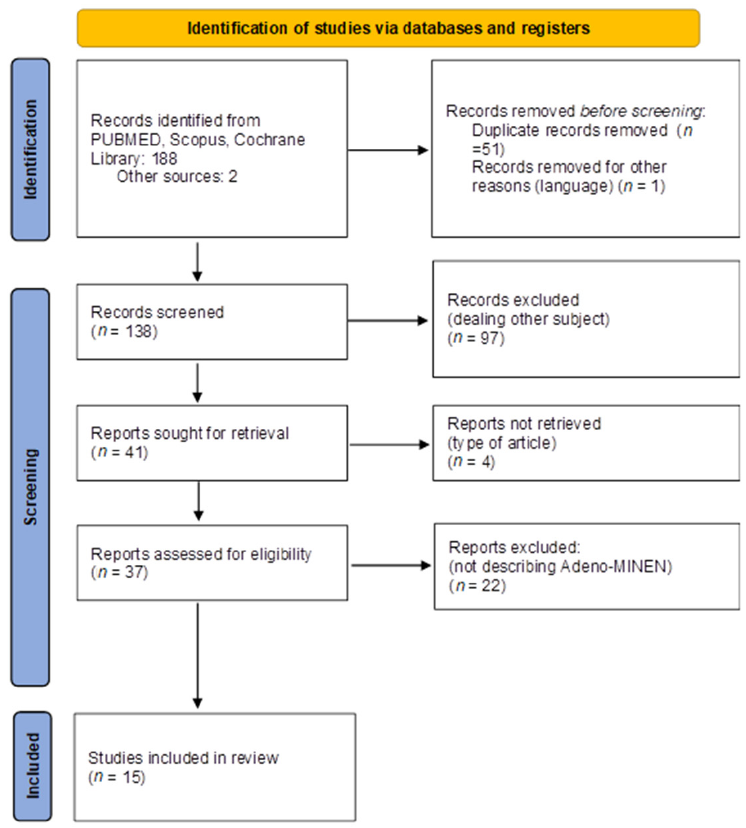
Figure 4. PRISMA 2020 flow diagram of systematic search.